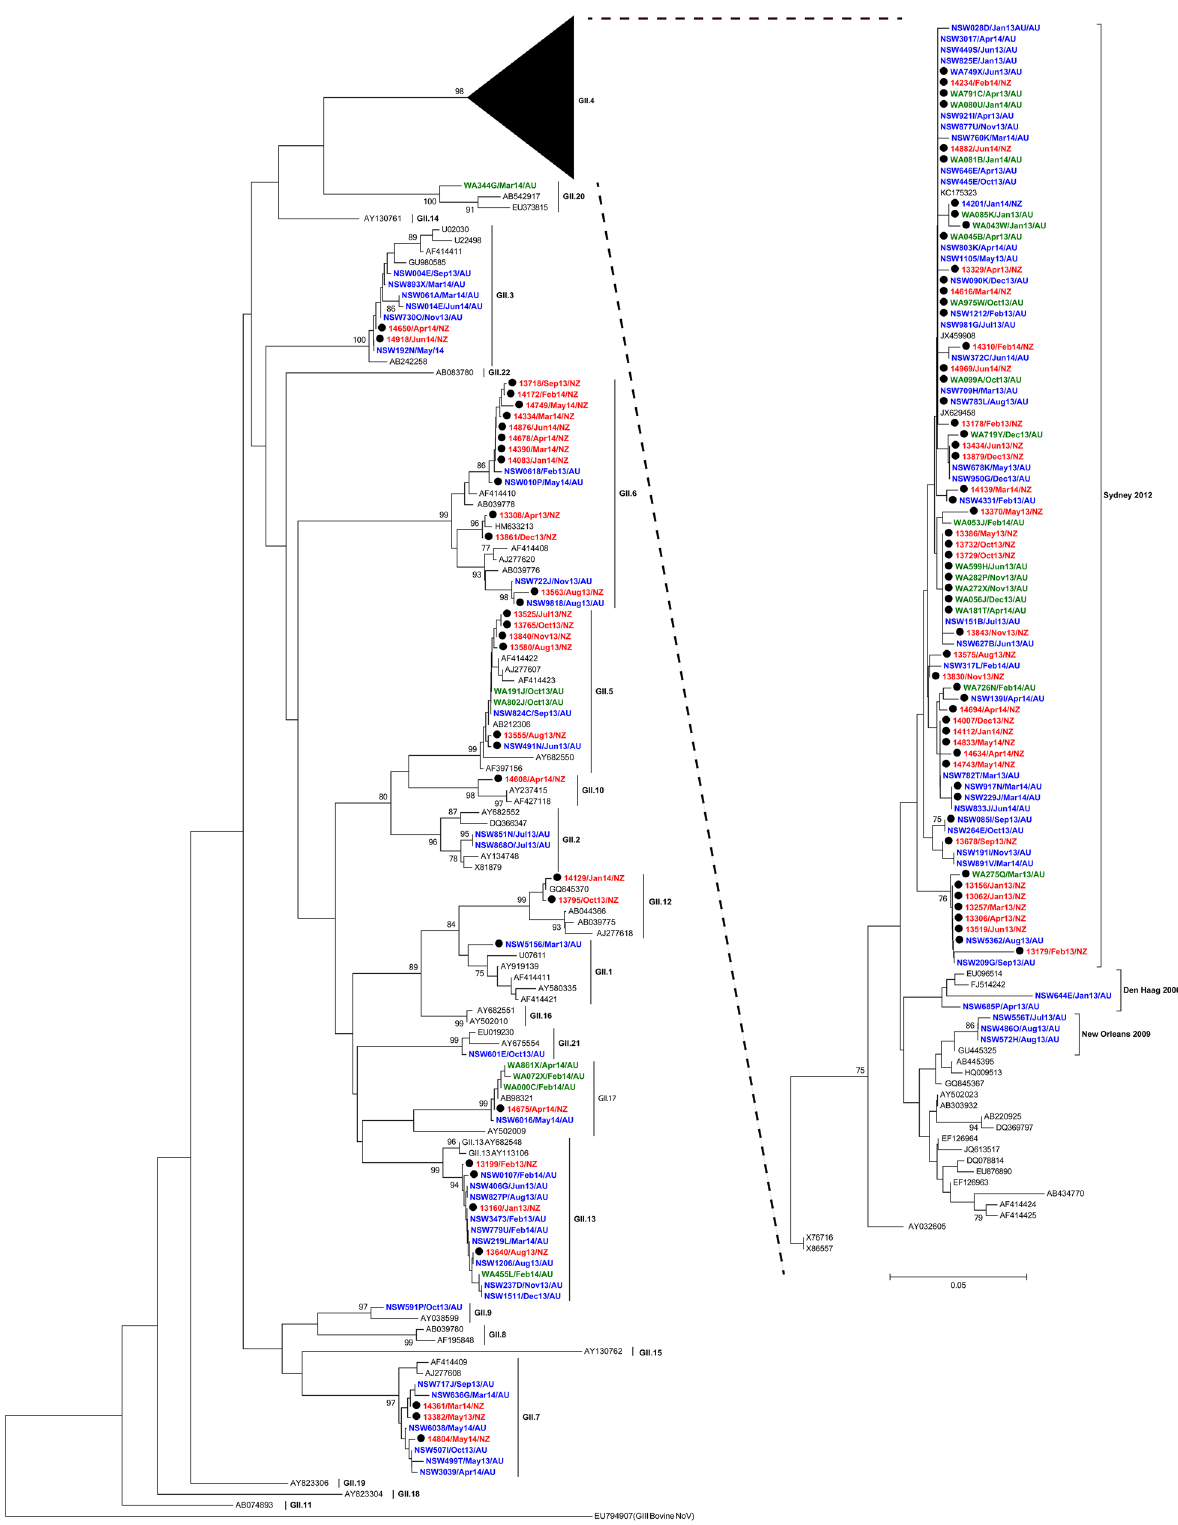
Fig 3. Phylogenetic analysis of NoV GII partial capsid nucleotide (nt) sequences from Australia and New Zealand. Neighbour-Joining phylogeny of sequences of the 5 ’ end of ORF2 was generated. NoV GII sequences (266-bp, nt position 5101 – 5366 with reference to Lordsdale virus, GenBank accession number X86557) are shown. Global NoV reference sequences (n = 78) genotype were obtained from GenBank and are labelled with the GenBank accession number in black. The detailed reference strain information and collection year are tabulated in S1 Table. Representative NoV sequences used for the PLOS ONE | DOI:10.1371/journal.pone.0145254 April 26,